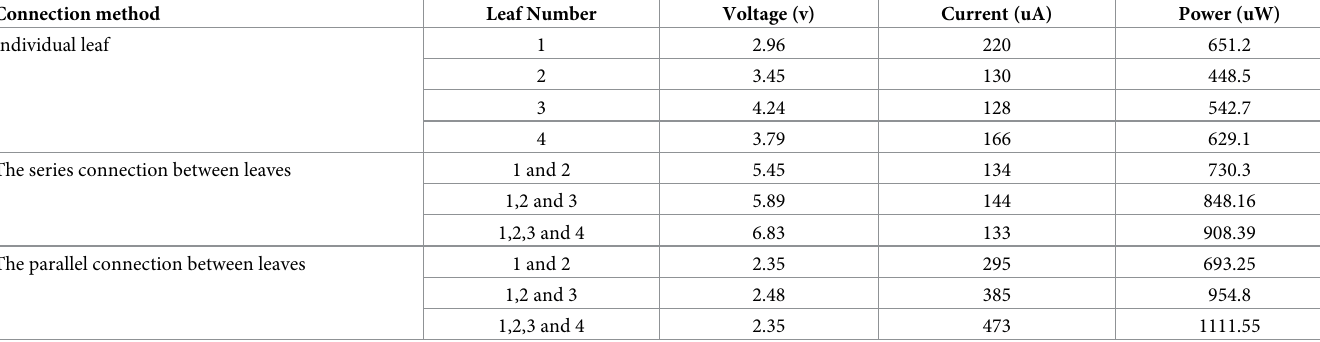
Table 6. Comparison of voltage and current from series and parallel connection between Aloe Vera leaves.